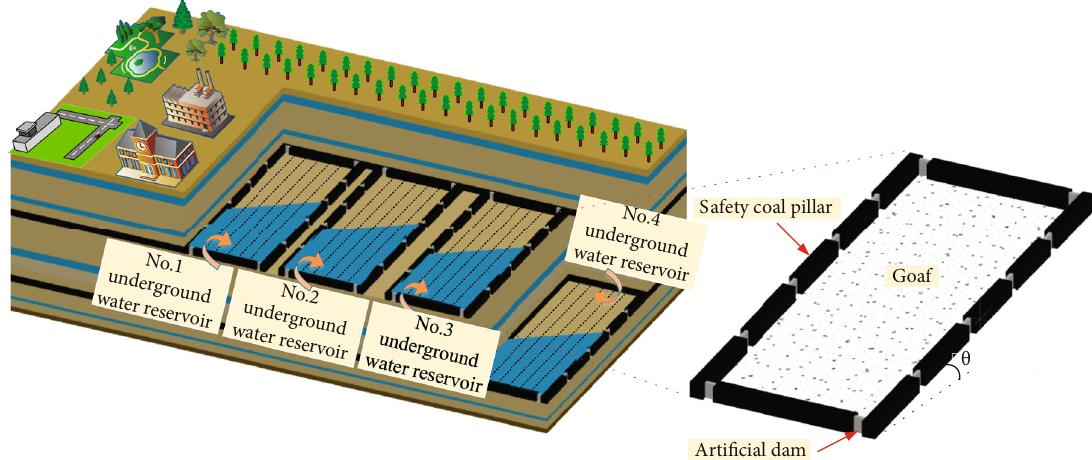
Figure 1: Schematic diagram of underground reservoir